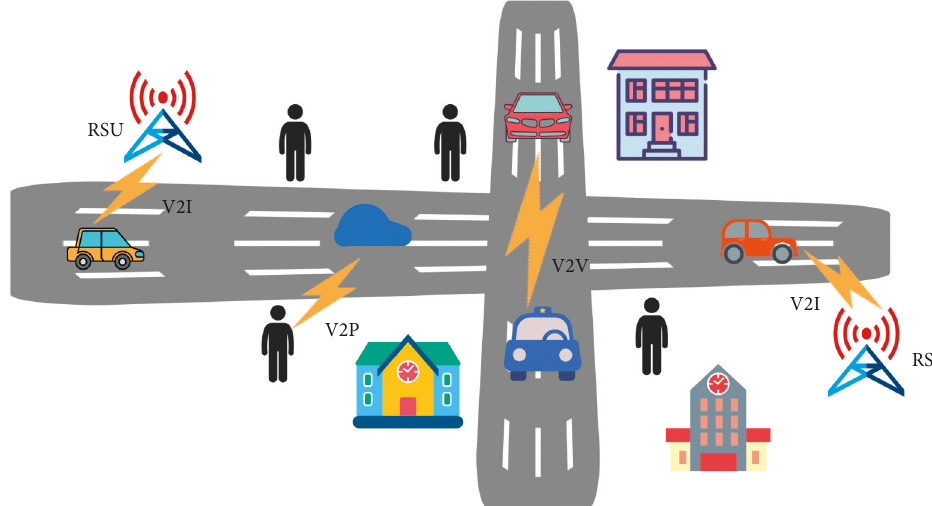
Figure 2: Schematic diagram of the basic architecture of IoV.